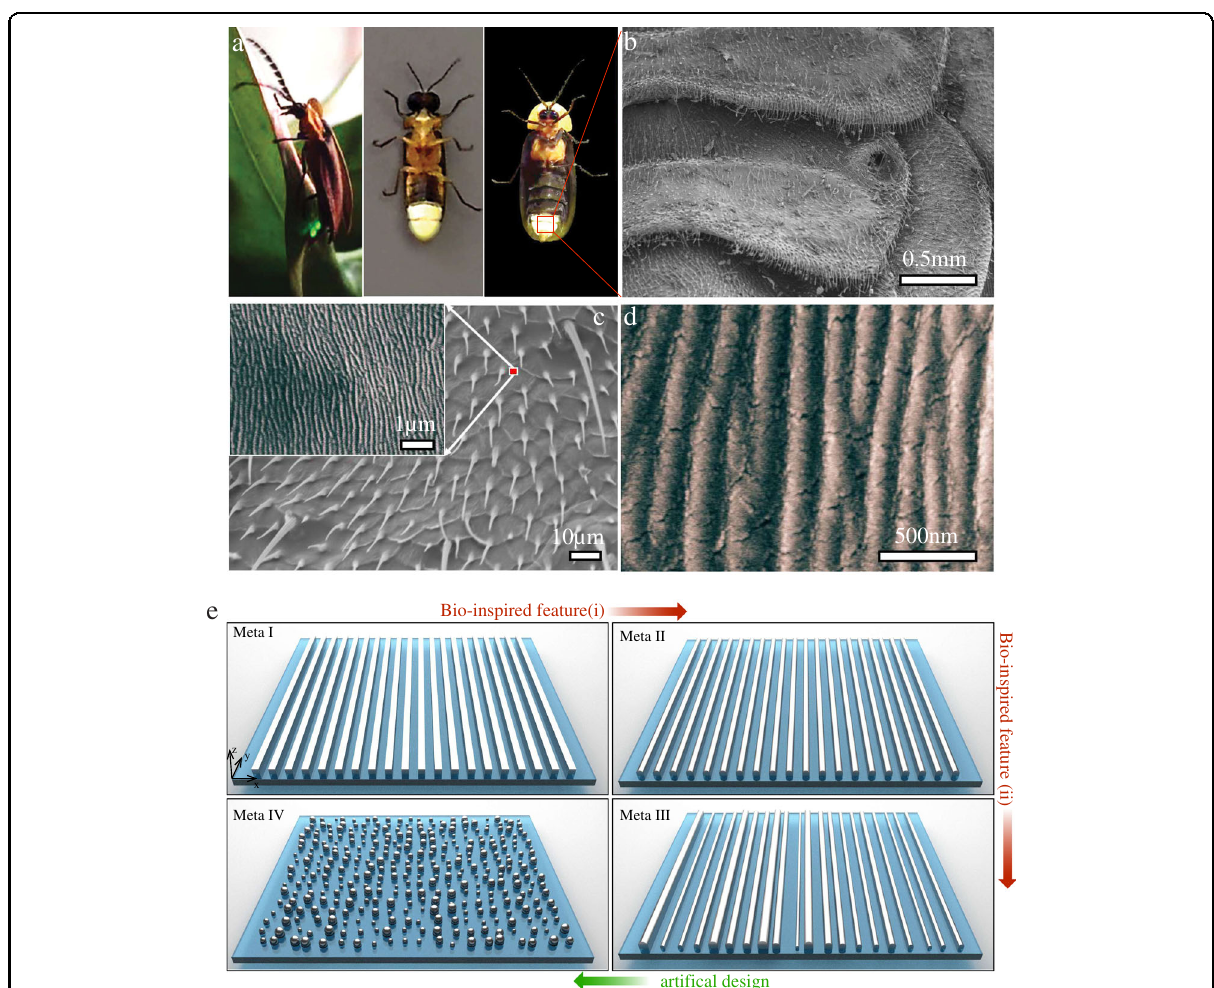
Fig. 1 Evolution-inspired design of disordered metasurface for light extraction. a Photo images of Photinus, Phausis reticulata and Pyrocoelia rufa. b The SEM image of lantern cuticles of Pyrocoelia rufa. c Enlarged view of microstructures on the lantern cuticle of the fi re fl y. The inset shows the microstructures with higher magni fi cation. The disorder in both position and size of stripes can be observed. d High magni fi cation SEM image of microstructure on the lantern cuticle. The curvature on the top surface for each stripe is clearly demonstrated. e The design fl ow of the metasurface. Meta-I is an ordinary metasurface composed of periodic stripes with squared cross-sections. Meta-I evolves to Meta-II and Meta-III by utilising two bio-inspired features, the curved top surfaces and disorder, respectively. Meta-IV endows extend features to another dimension, transforming stripes to